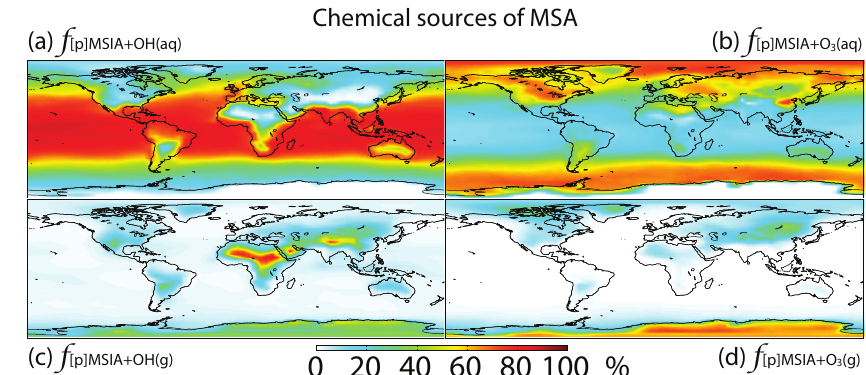
Figure 8. Global tropospheric distribution of annual-mean percentage of MSA produced in the troposphere via (a) MSIA + OH ( aq ) ( f [ p ] MSIA + OH ), (b) MSIA + ,O 3 ( aq ) ( f [ p ] MSIA + O ( aq )